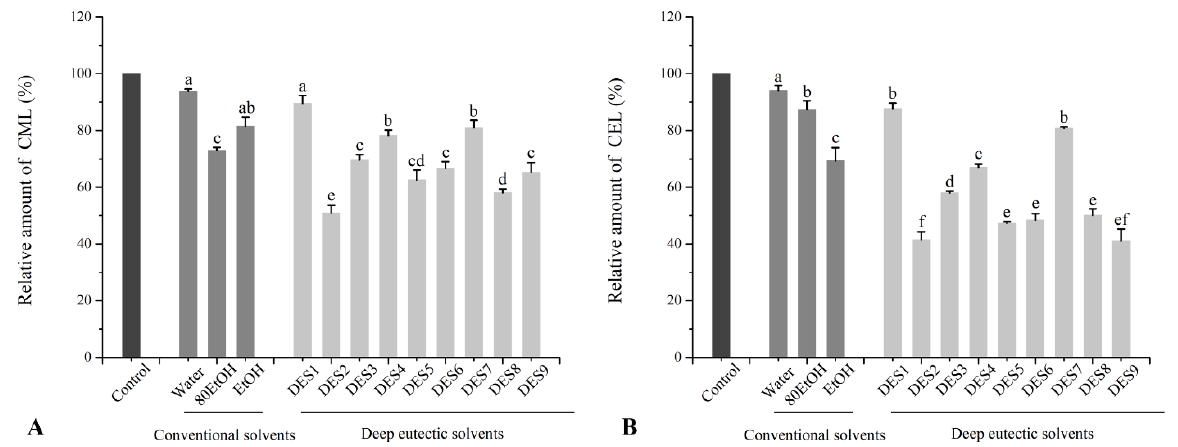
Figure 4. Relative amounts of ( A ) CML and ( B ) CEL in roasted beef patties with different ginger extracts. The corresponding to the solvent’s abbreviations can be consulted in Table 1. Values are expressed as mean ± SD ( n = 3). Different letters in each series indicate significant differences ( p < 0.05); lowercase letters denote significant differences ( p < 0.05) between solvents.